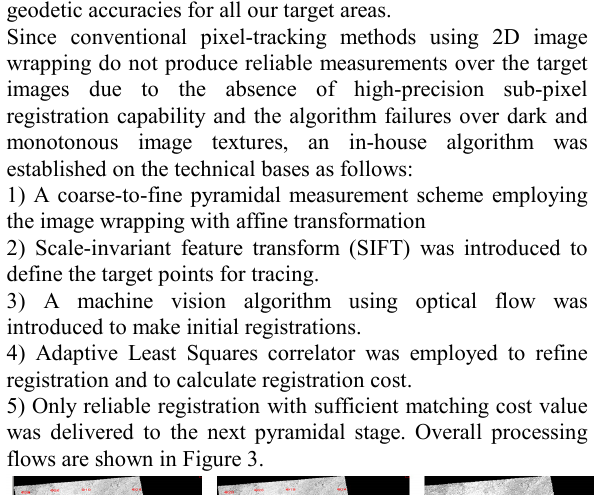
Figure 1. The locations of three target areas, Kaiser, Proctor and Witz for dune migration measurements and their Context Camera (CTX) and HIRISE images